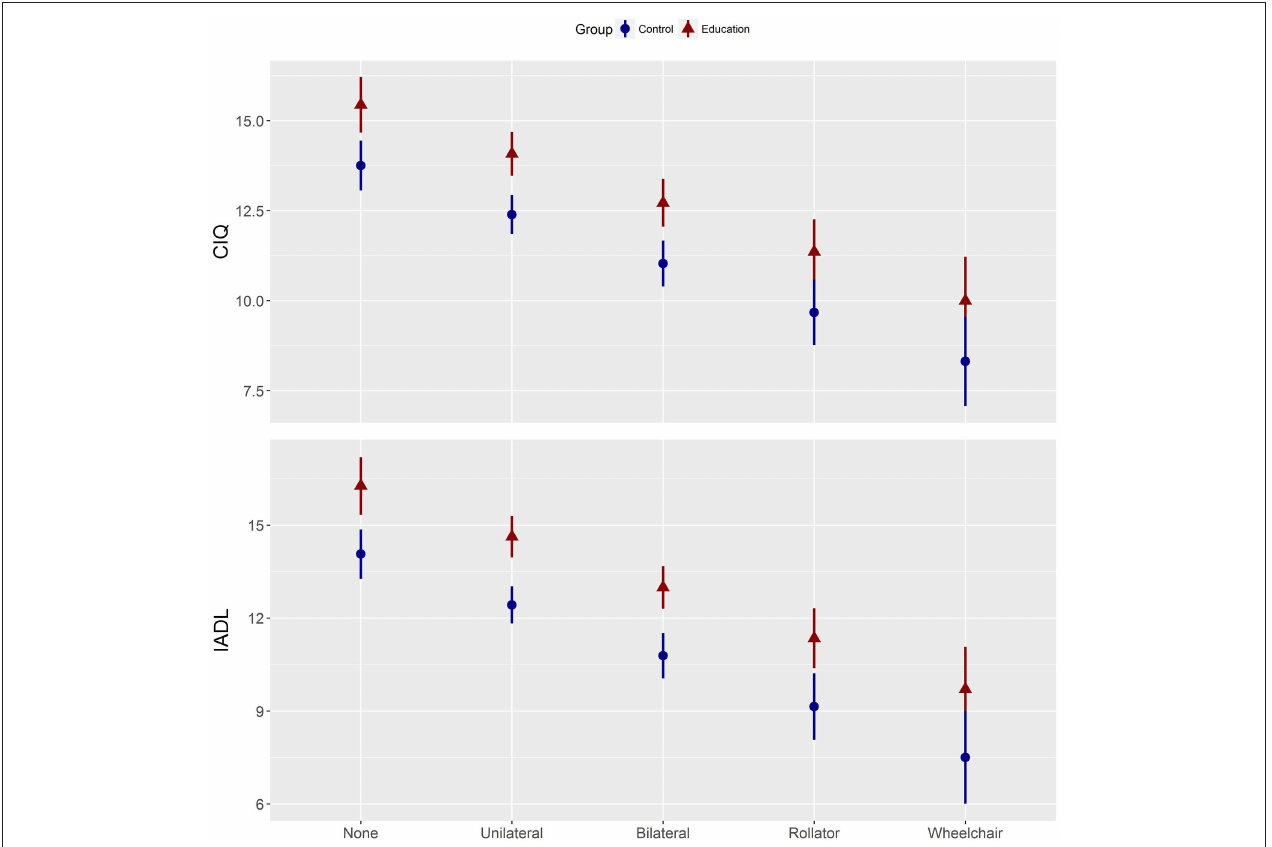
FIGURE 4 | Participation and activity of daily living post-scores adjusted for pre-scores. CIQ, Community Integration Questionnaire; IADL, Instrumental Activities of Daily Living; Control, home-based stretching exercises group; Education, combined education and tailored home-based exercises (experimental) group.